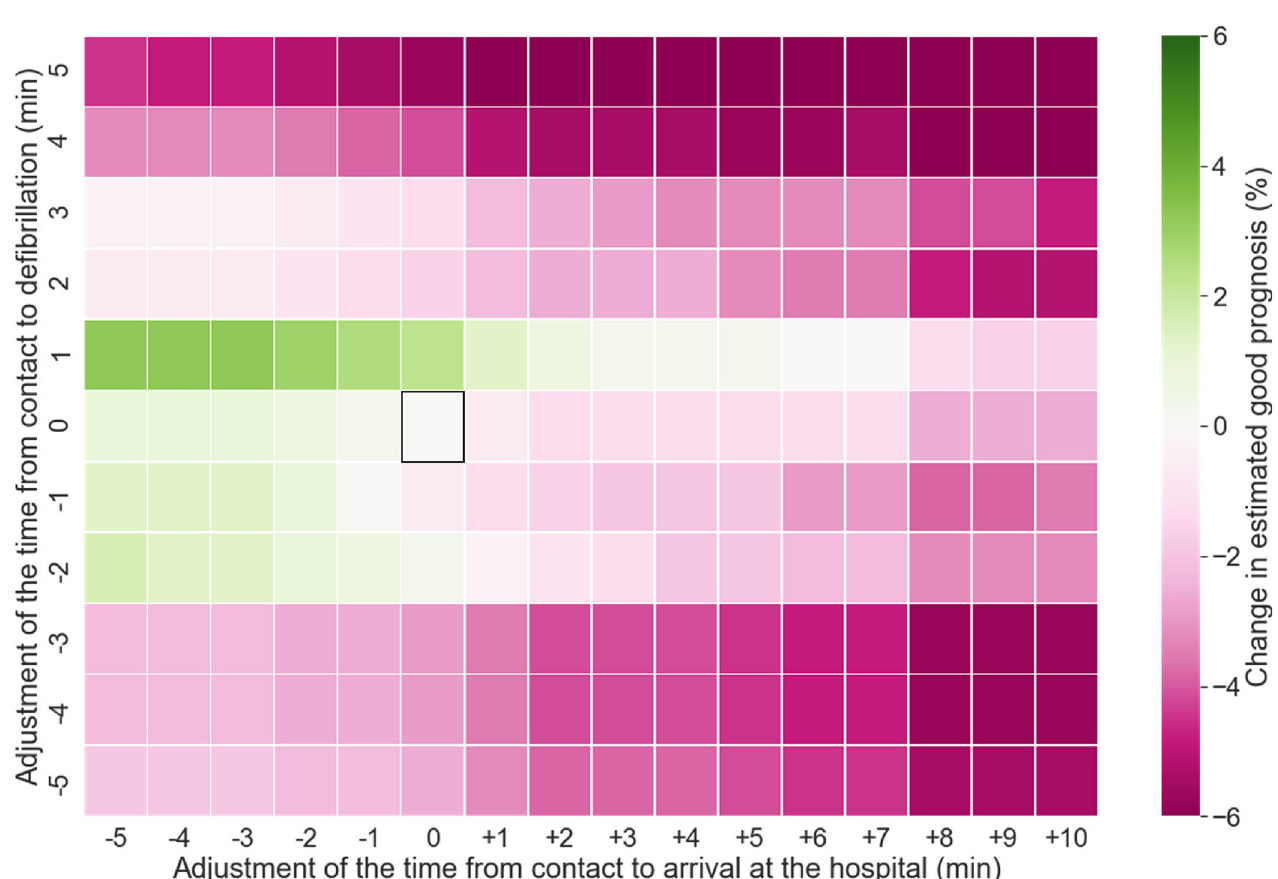
Fig 4. Modification of time from ambulance contact to hospital arrival and first defibrillation. The square box indicates no adjustments. The two ends of the color spectrum show a 6% increase and decrease in predicted CPC1/2, respectively. Overall, reducing the time for hospital arrival improved outcomes, whereas delays worsened them. A reduced time to defibrillation strengthened this trend, but it was obscured when the time to defibrillation was reduced by more than 3 min or delayed by more than 2 min. CPC, cerebral performance category.